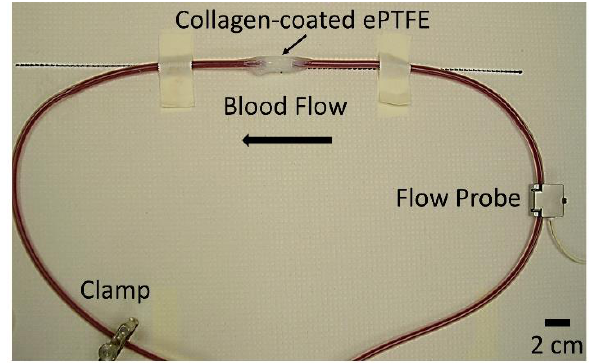
Figure 1. Apparatus for ex vivo arteriovenous shunt loop whole blood testing. In this case, a 2 cm length, 4 mm inner diameter collagen-coated expanded polytetrafluoroethylene (ePTFE) sample in the testing position is shown. Scale bar = 2 cm.